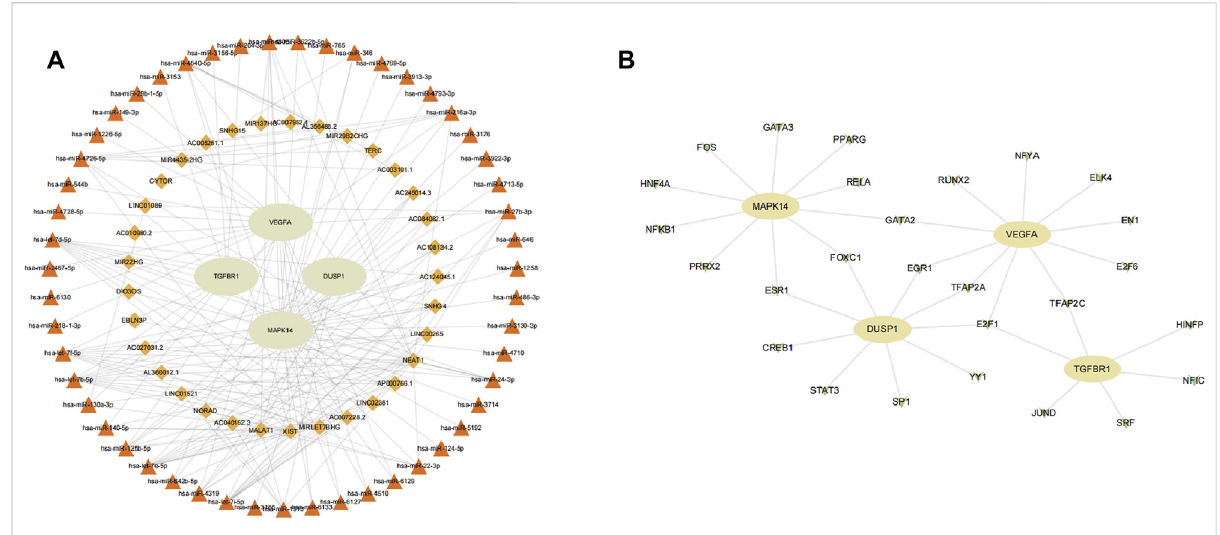
FIGURE 9 Network construction. (A) ceRNA network of key ferroptosis-related differentially expressed genes (DEGs). (B) TF – gene network of key ferroptosis-related DEGs. Ellipse nodes are genes, diamond nodes are lncRNAs, triangle nodes are miRNAs, and V nodes are